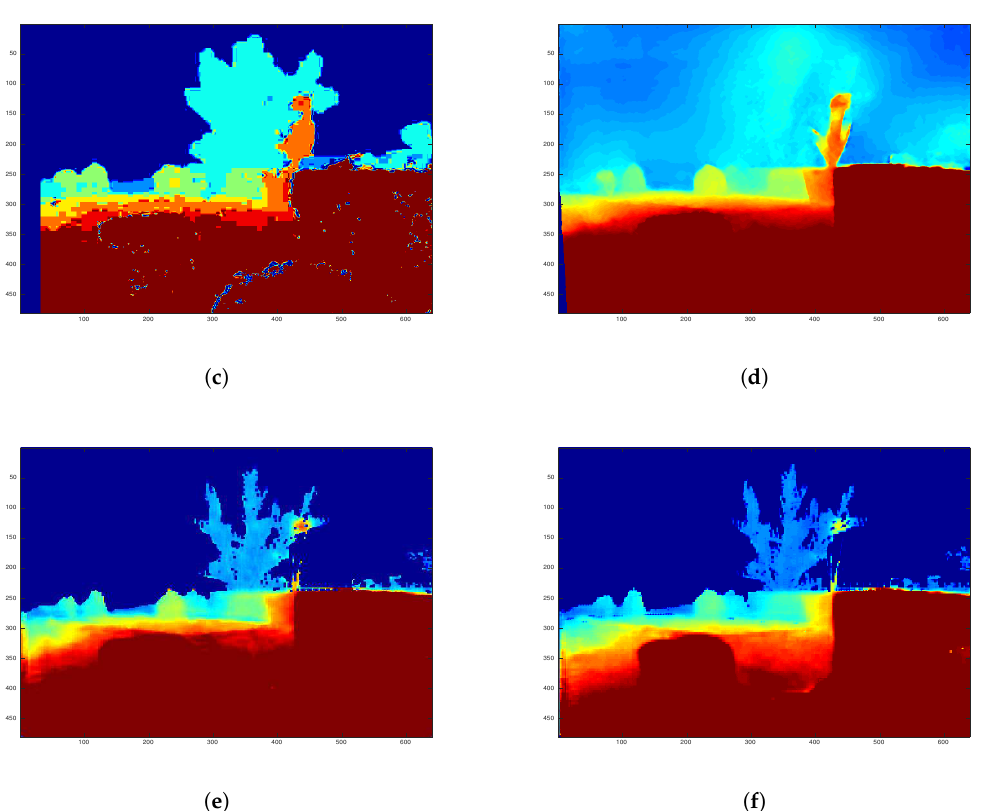
Figure 4. We fuse two initial raw disparity inputs ( c , d ) to get a refined disparity map ( e , f ) using our Supervised and Semi method on the synthetic garden dataset. ( a ) is the ground truth and ( b ) is the corresponding scene. Many, but not all, pixels from the fused result are closer to ground truth than the original inputs. ( a ) Ground Truth; ( b ) Scene; ( c ) FPGA Stereo [3]; ( d ) Dispnet [4]; ( e ) Our Supervised; ( f ) Our Semi.